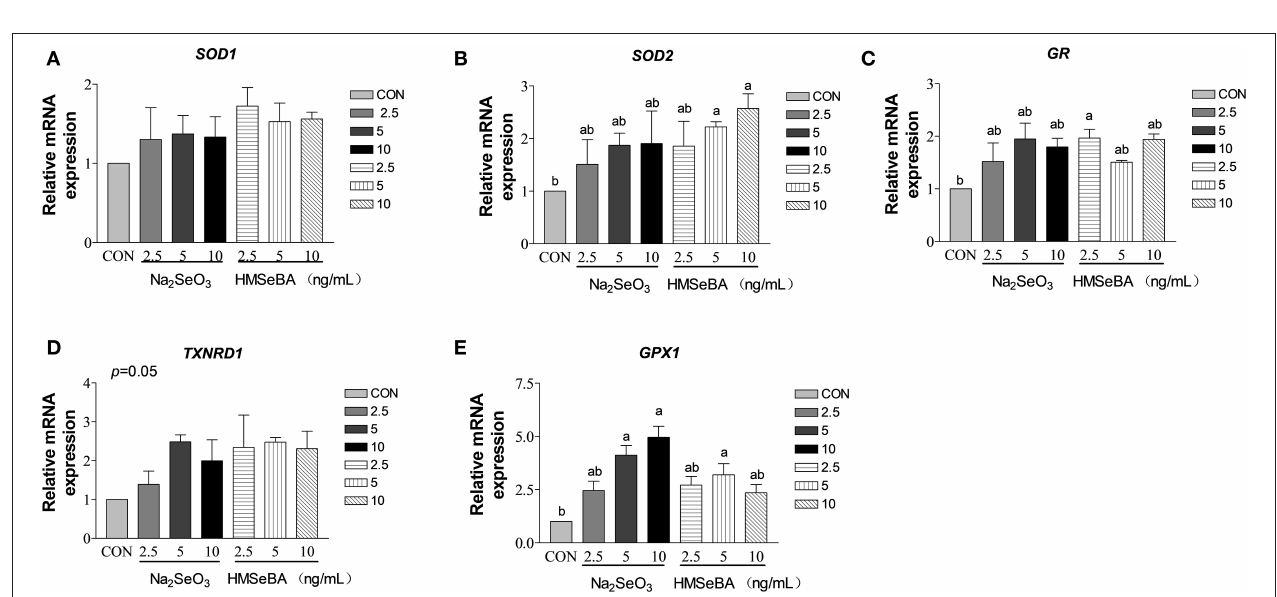
FIGURE 7 | Effects of selenium from different sources and concentrations on the oxidative stress status in the granulosa cells in vitro . (A) T-AOC activity, (B) T-SOD activity, (C) GPX activity, (D) GR activity, (E) TXNRD, and (F) MDA in the granulosa cells in vitro . Data are expressed as means values and standard error. a,b Mean values with different superscript letters were significantly different ( P < 0.05). CON: basal media, Na 2 SeO 3 2.5, 5 and 10 ng Se/ml, HMSeBA 2.5, 5, and 10 ng Se/ml.